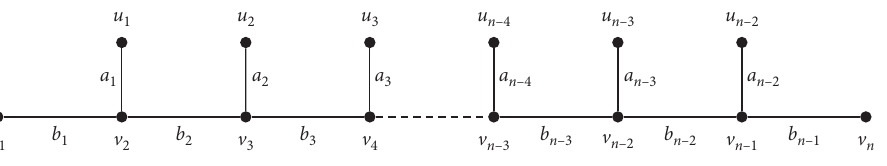
Figure 7: The graph T n,n − 2 with ordinary labeling.